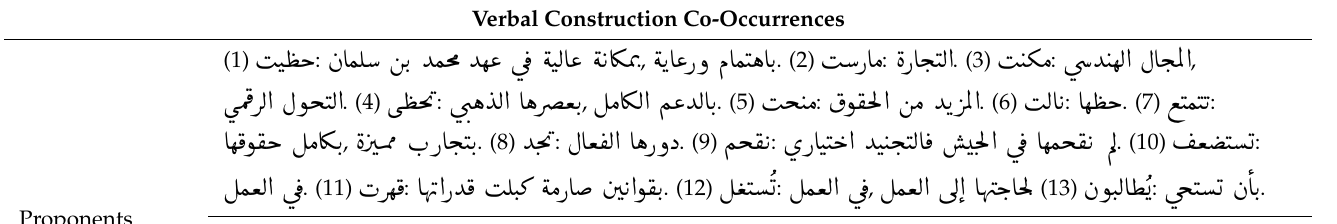
Table 13. Broad contexts of the verbal construction co-occurrences ( rf = >0.00001 × 100). Verbal Construction